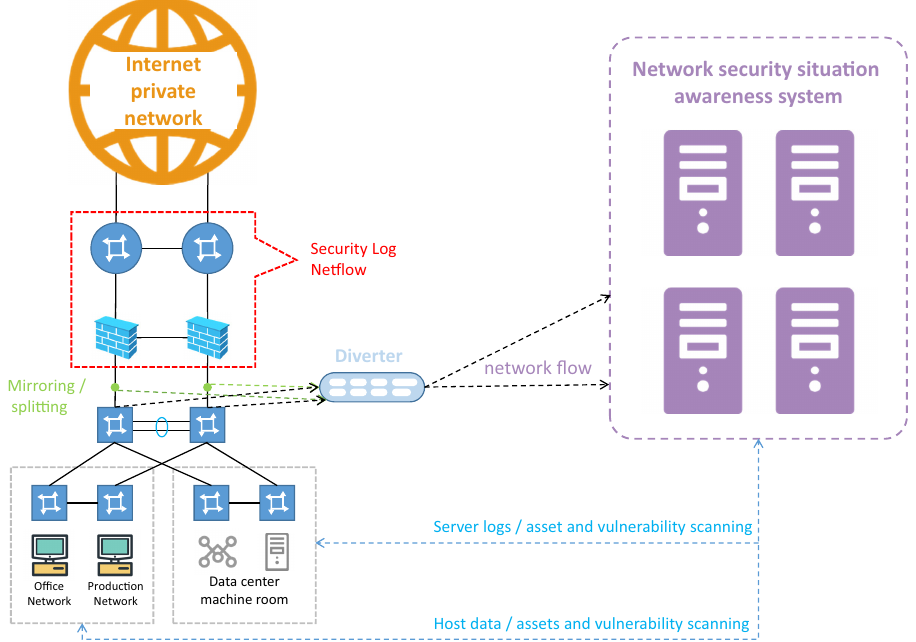
Figure 1: Network security situational awareness technology application